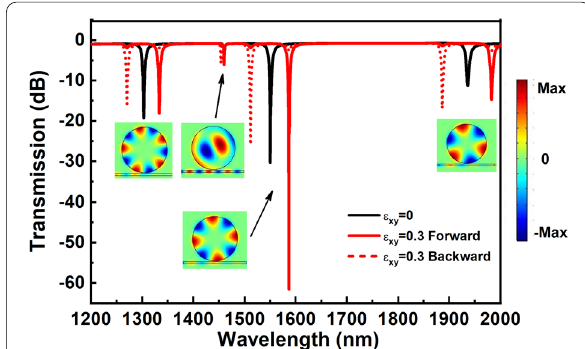
Fig. 2 The total transmission spectra of the optical isolator structures for different ε xy . The solid black line shows the transmission spectrum for ε xy = 0 , solid red line for ε xy = 0.3 forward and the dotted red line for ε xy = 0.3 backward. The insets below the transmission spectra are the intensity distributions of the z component of the magnetic field, corresponding to the case of ε xy =